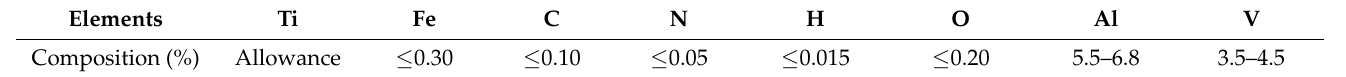
Table 2. Chemical composition of Titanium alloy